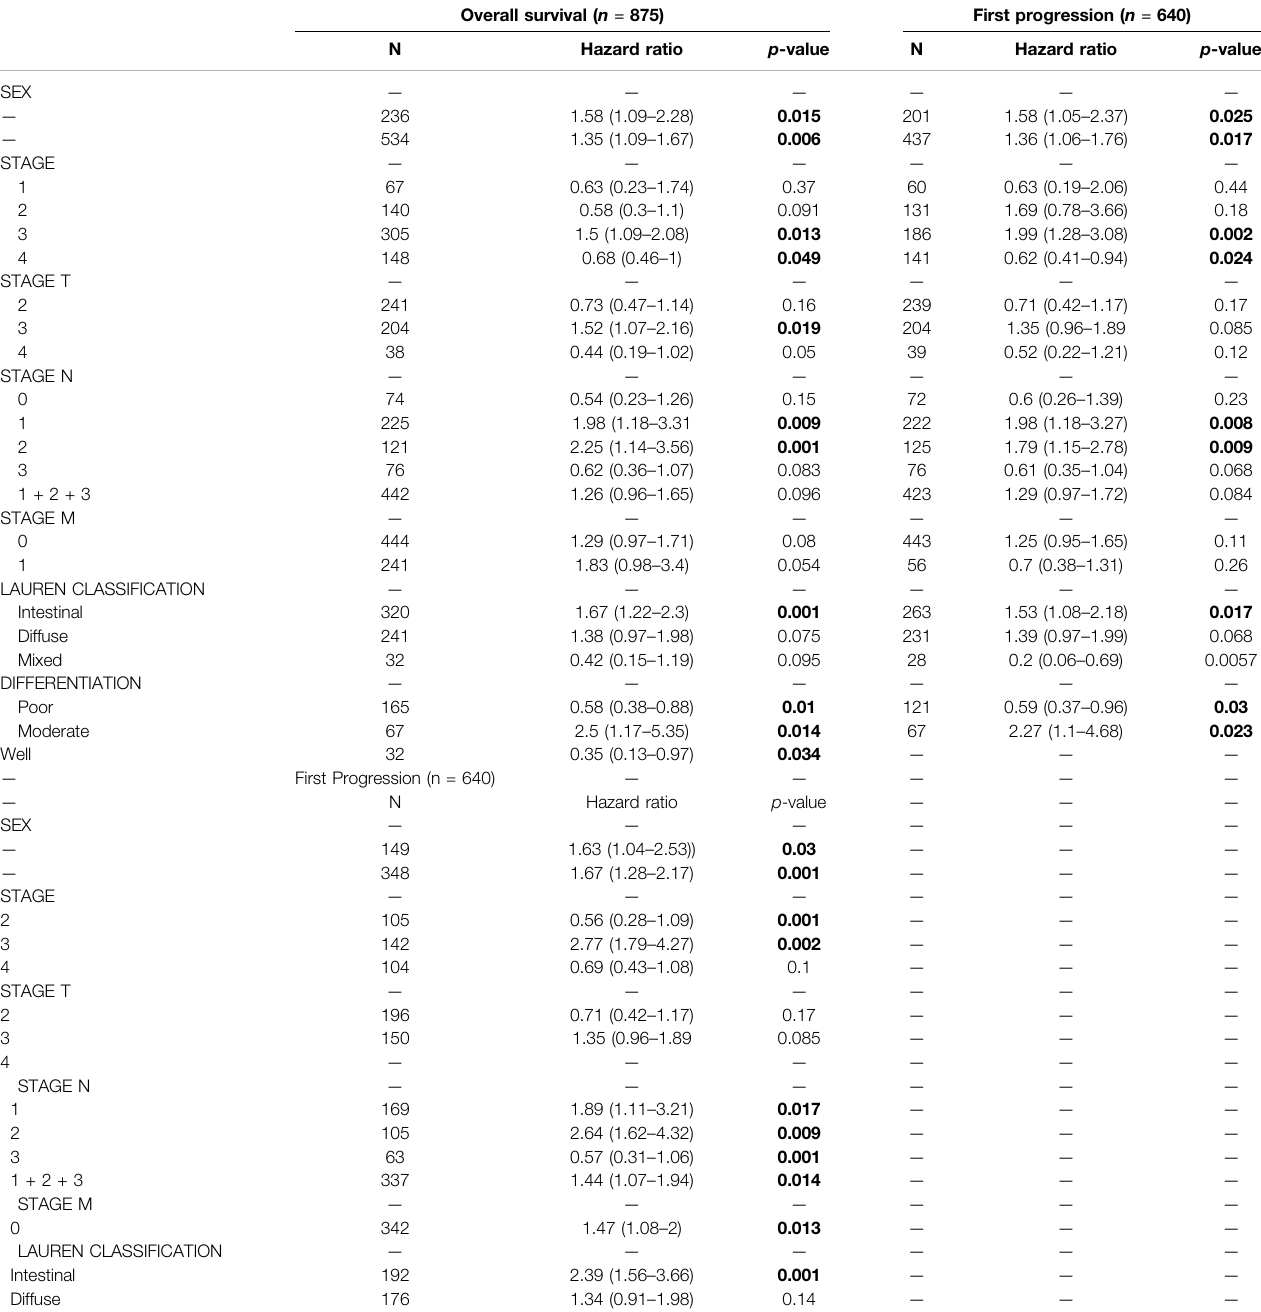
TABLE 1 | Correlation of EFNA3 mRNA expression and clinical prognosis in gastric cancer with different clinicopathological factors by Kaplan-Meier plotter Clinicopathological characteristics. Bold values indicate p < 0.05. Overall survival ( n =